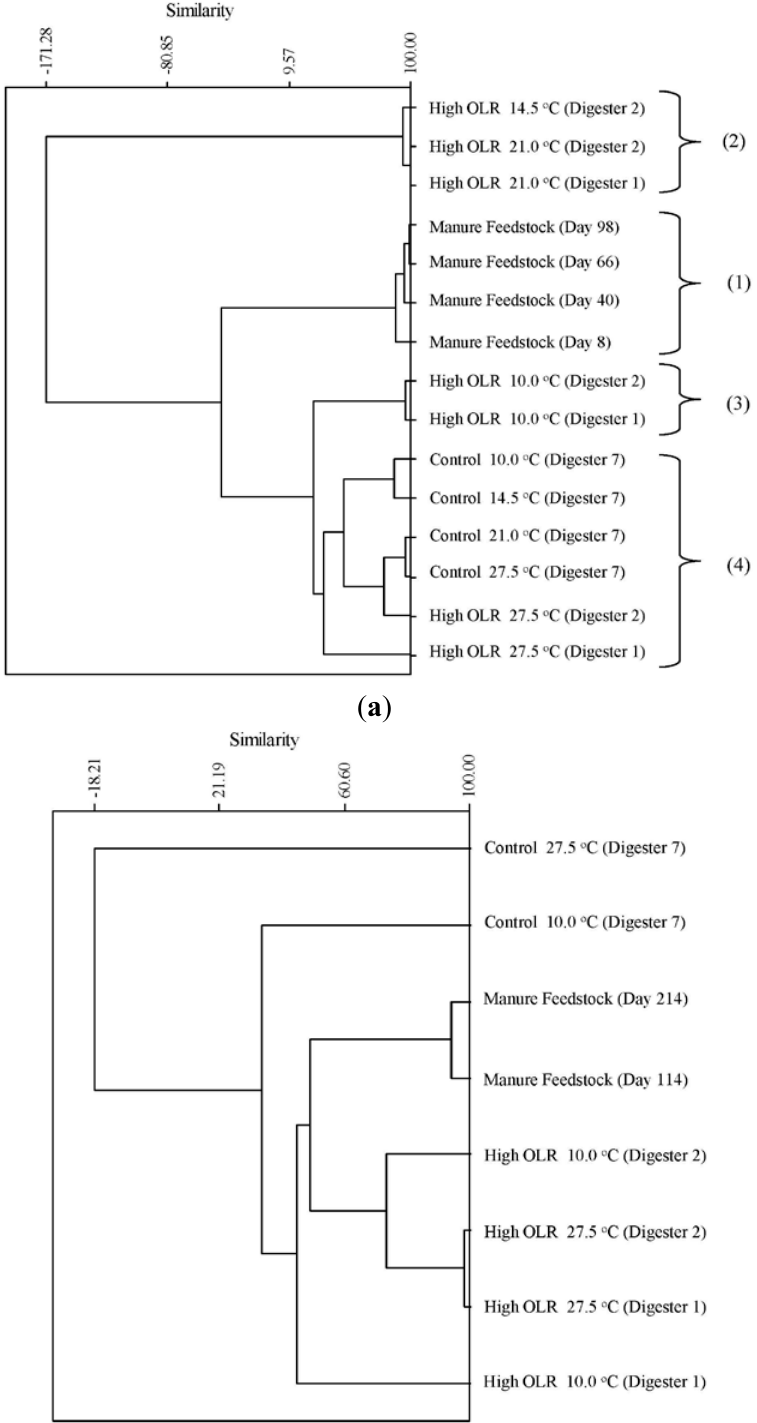
Figure 2. Archaeal community cluster dendrograms for the High OLR digesters during the decreasing ( a ) and increasing and ( b ) temperature